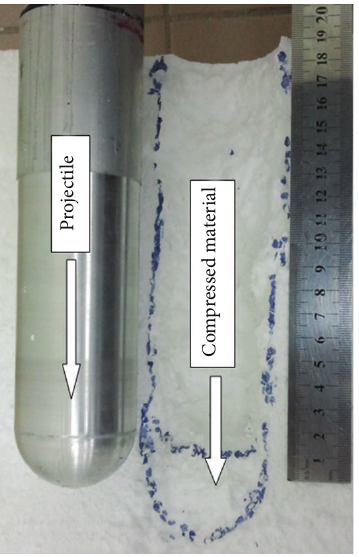
Figure 6: Depth of penetration of projectile into EPS foam speci-